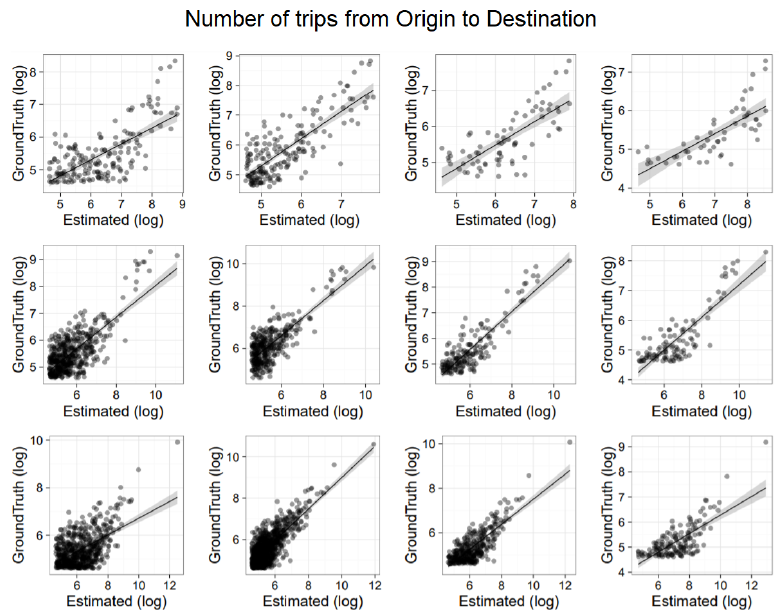
Figure 8. Comparison of time-based matrices with ISTAT. ( top row ) provides results for Piemonte. ( middle row ), for Emilia Romagna. ( bottom row ), for Lombardia. In each row, we have 4 correlations associated to the four time intervals in which ISTAT data is organized, that is travel from home to work ( i ) before 7 a.m.; ( ii ) from 7 a.m. to 8 a.m.; ( iii ) from 8 a.m. to 9 a.m.; ( iv ) after 9 a.m.